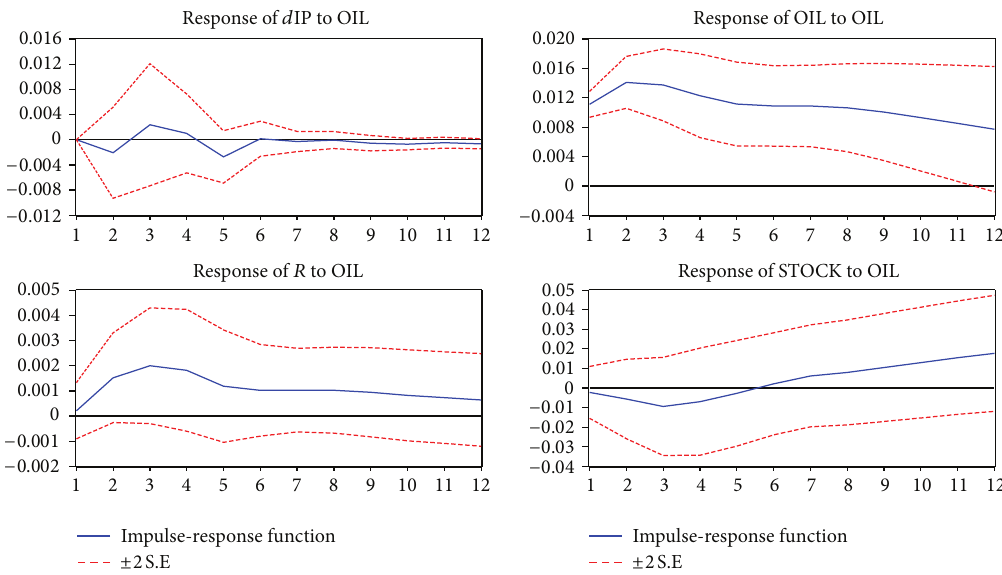
Figure 1: Generalized impulse responses to one S.D. shock for energy price changes. Note that the horizontal axis is the period. The vertical axis is the explanation level of dependent variables to independent variables. In the model, we fix the periods at 12 months.